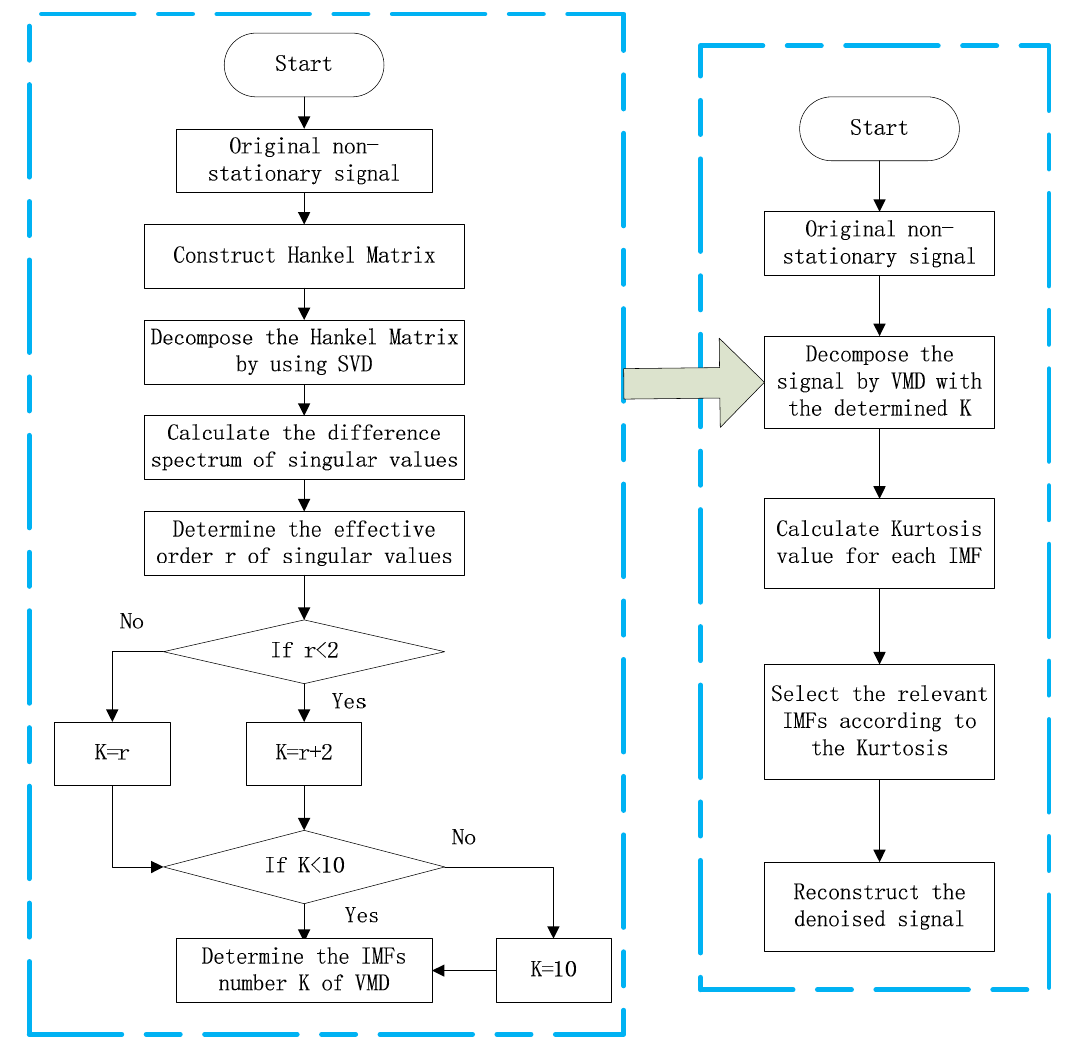
Figure 1. Flowchart of the proposed SVD-VMD denoising